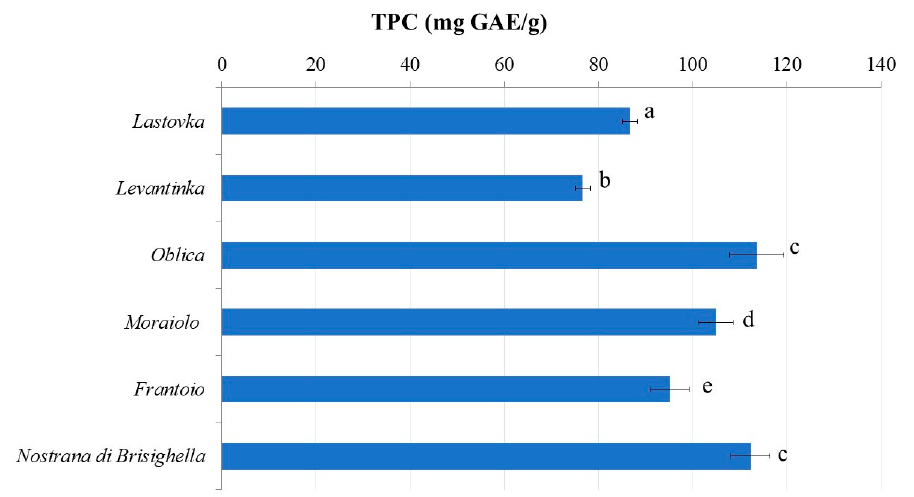
Figure 1. The content of total phenolics (TPCs) in olive leaf (in mg of gallic acid equivalents (GAEs) per g of dry extract ( n = 4). Columns marked with different letters are statistically different ( p < 0.05).